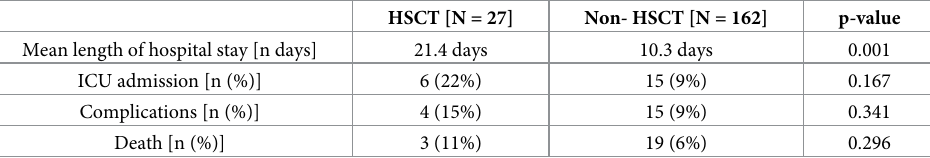
Table 7. Comparison of outcomes from viral infection episodes between HSCT and non-HSCT recipients.